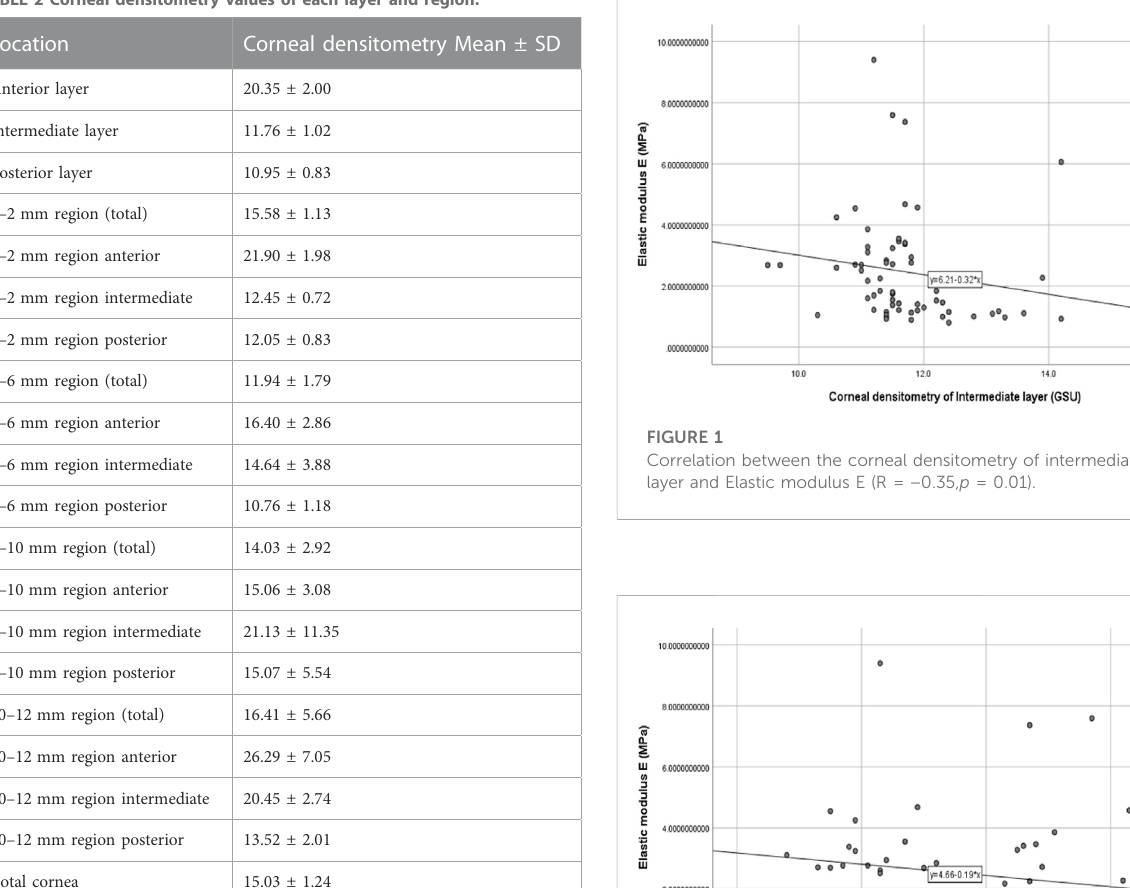
TABLE 2 Corneal densitometry values of each layer and region.